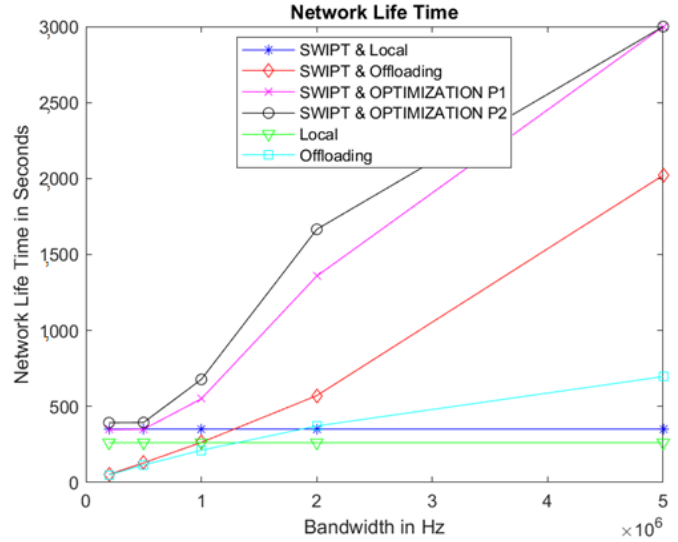
Figure 7. Network lifetime for variable bandwidth.